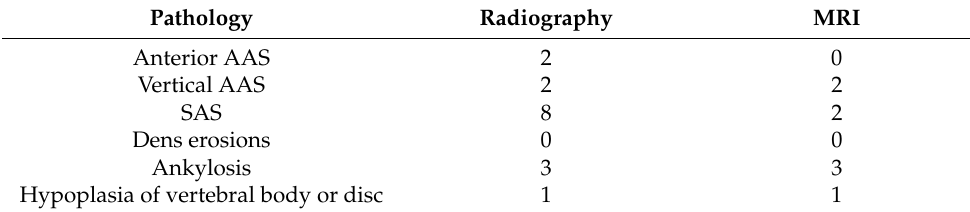
Table 3. Number of patients with JIA (total n = 34) with lesions diagnosed on radiography and MRI. Pathology